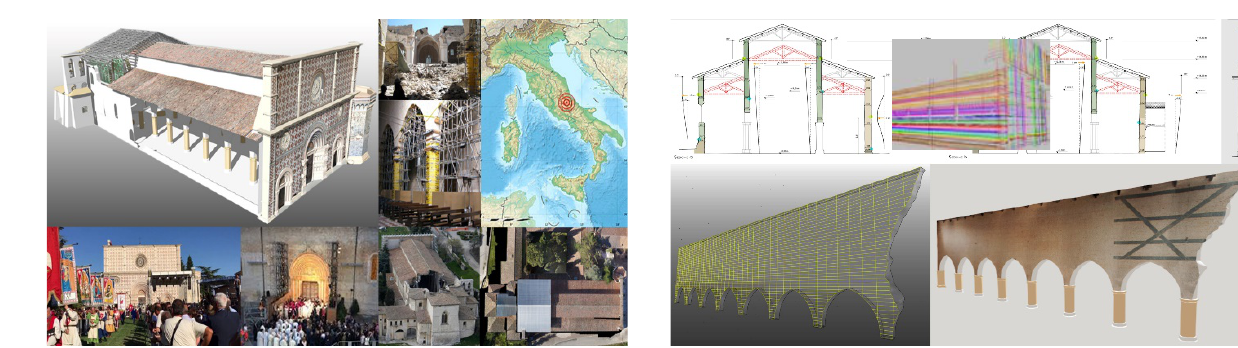
Figure 1. Earthquake damages, the Holy Door during the Figure 2. From multi-sliced wireframe to the NURBS-based complex modeling followed for each 3D parametric